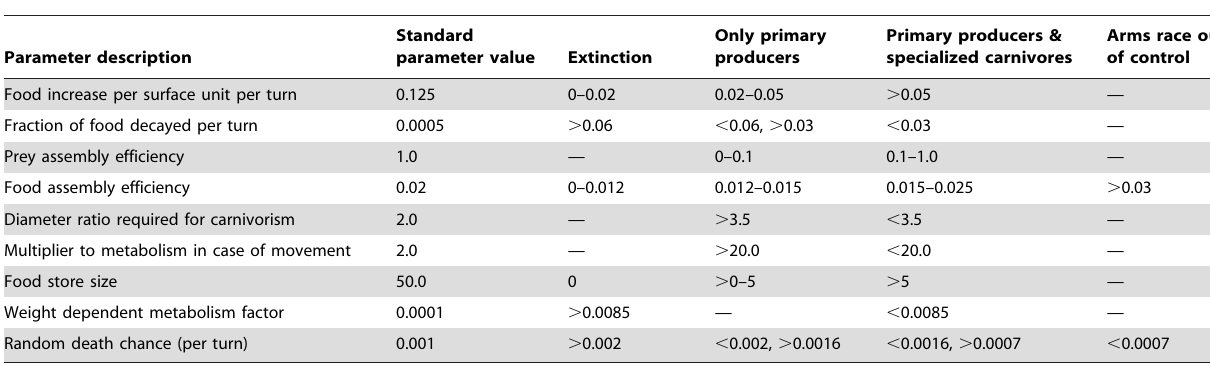
Table 1. Some standard values for parameters, and their effects.